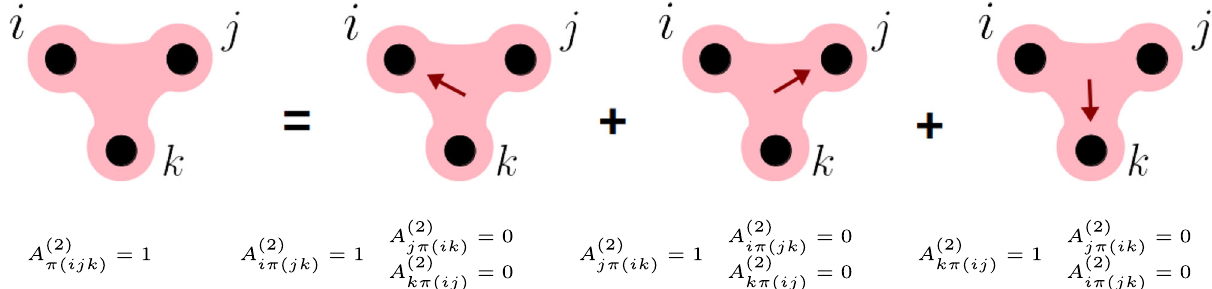
Fig. 1 Elementary decomposition of undirected hyperedges. An undirected 2-hyperedge can be seen as the composition of three directed hyperedges. In each of the three directed 2-hyperedges, the nodes acting as source of the interaction are interchangeable, i.e., switching them does not alter the nature of the interaction. Therefore, the adjacency tensors A (2) is symmetric to a permutation of the indices corresponding to the source